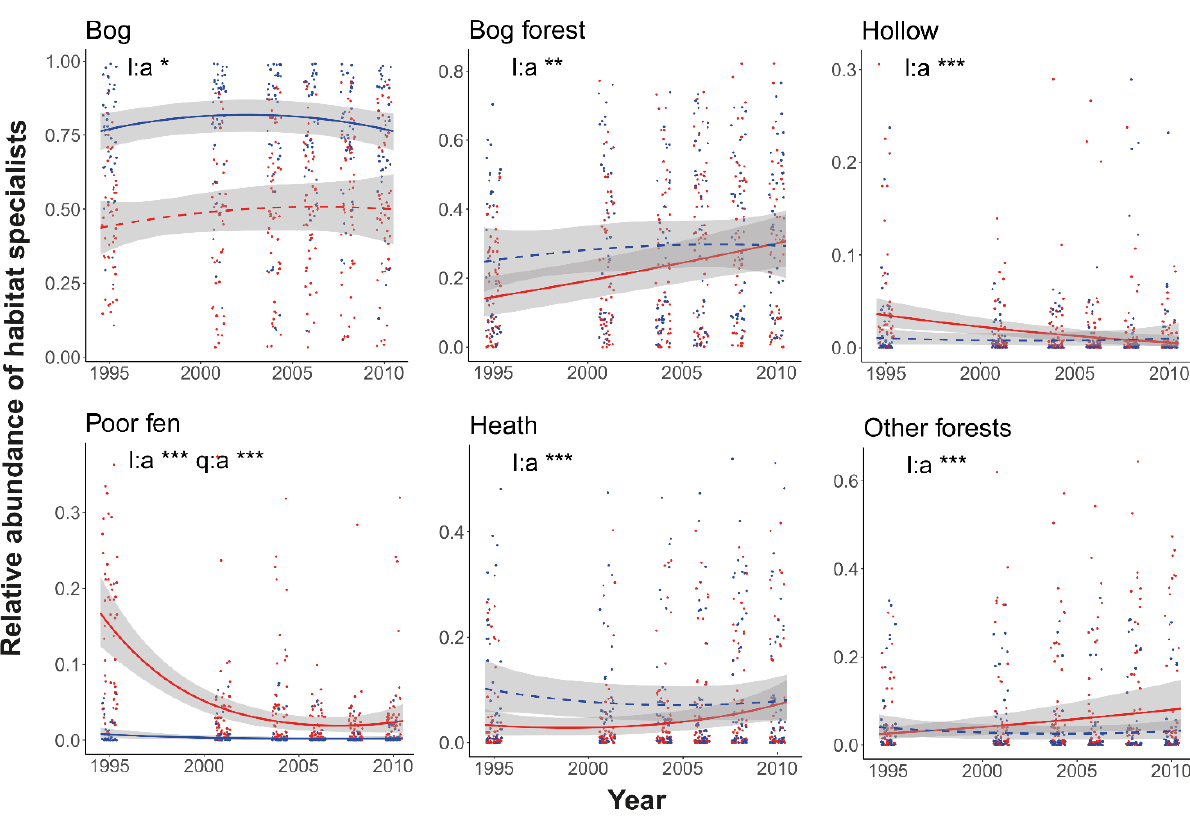
Figure 5. Trends of relative abundance of habitat specialists for GC-areas (grazing cessation, red) and GCR- areas (grazing cessation plus rewetting, blue). Regression lines and confidence intervals from individual models are displayed. Solid lines show significant trend components. Dashed lines show the model fit of both trend components, if neither of them is significant. Labels denote significant trend differences or significant overall trends derived from the common model. Dots indicate observed values on single plots. Outliers are not shown. l = linear time component; q = quadratic time component; a = area type; a colon indicates an interaction. Significance levels: *: p ≤ 0.05; **: p ≤ 0.01; ***: p ≤